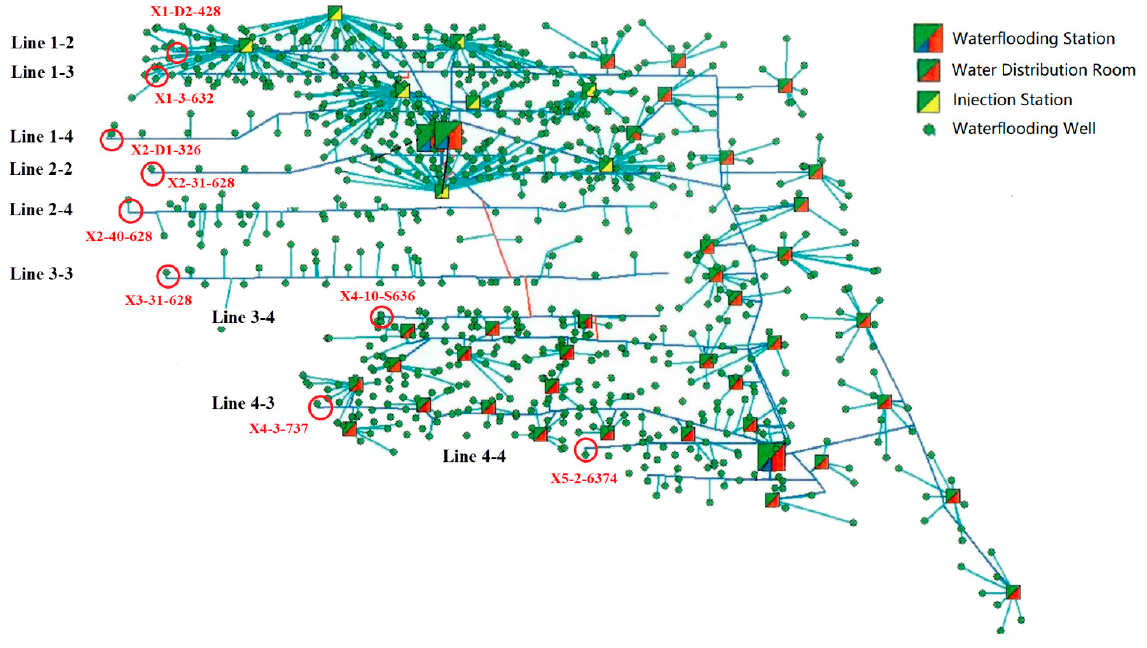
Figure 11. Cut-off position of the pipe network.